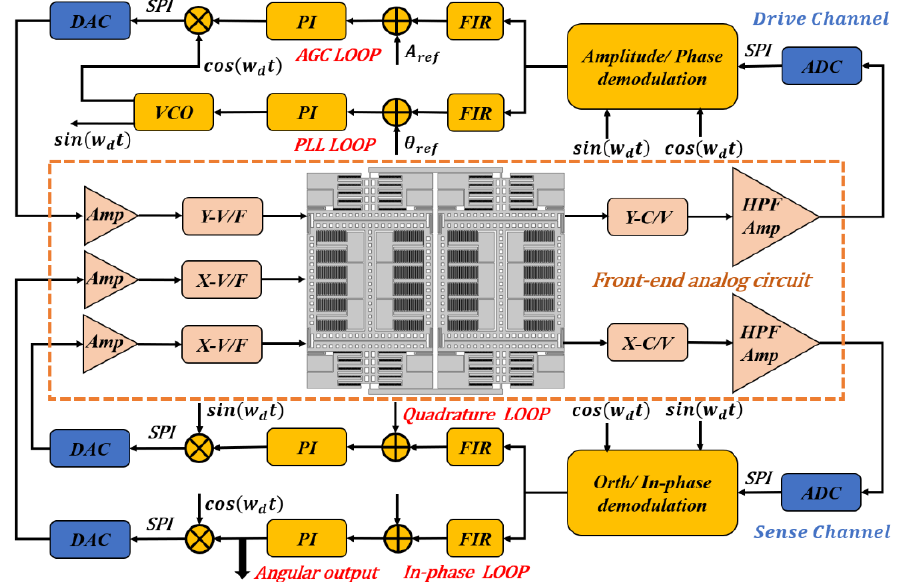
Figure 3. A block diagram of the control circuit system.